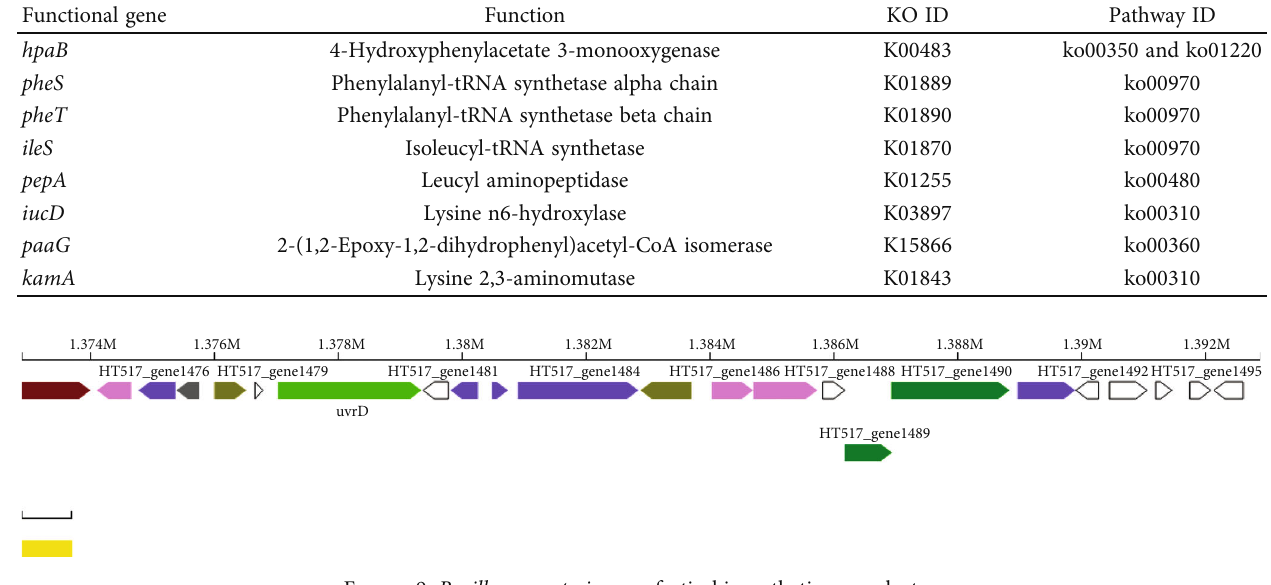
Figure 9: Bacillus megaterium surfactin biosynthetic gene